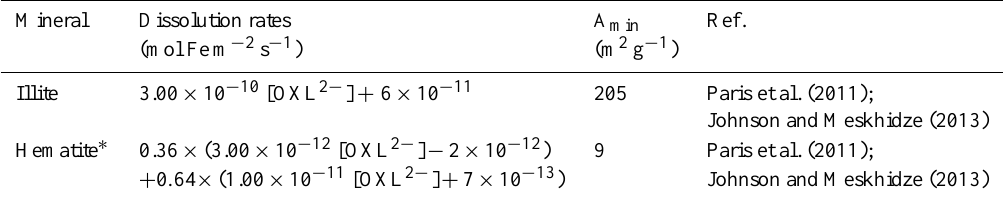
Table 3. Constants used for ligand (oxalate)-promoted iron dissolution from illite and hematite.